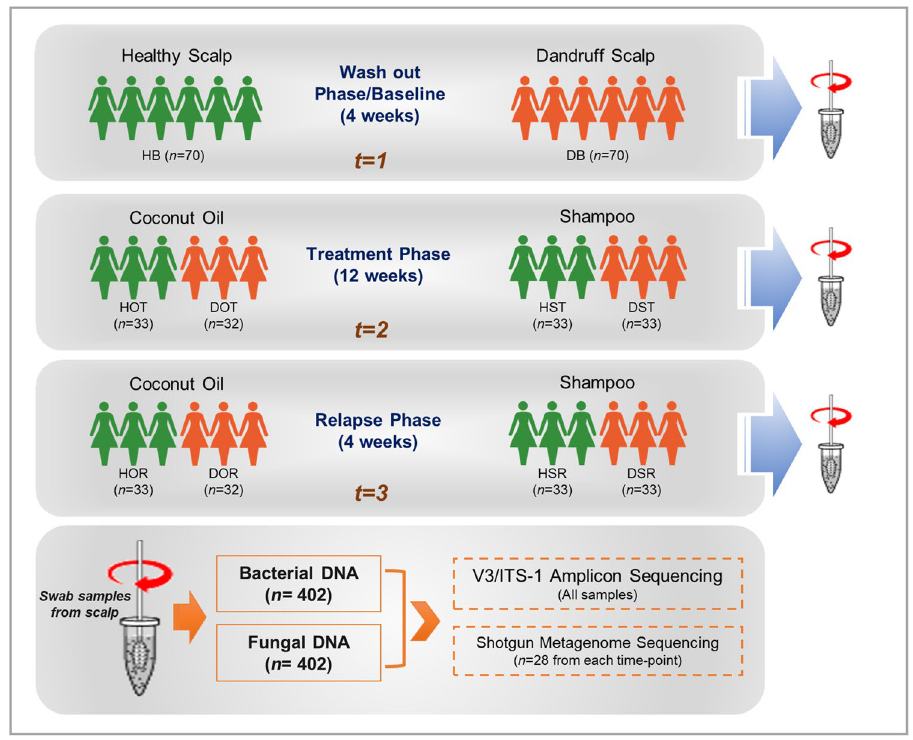
Figure 1. Study Design. Swab samples were collected at three phases, baseline ( t = 1), treatment phase ( t = 2) and relapse phase ( t = 3) from healthy and dandruff scalps. Bacterial and fungal DNA was extracted from the collected swab samples, and amplicon (bacterial 16S rRNA V3 and fungal ITS1 region) and shotgun metagenomic sequencing were performed to carry out the taxonomic and functional analysis. In the figure, H = healthy scalp, D = dandruff scalp, O = oil-treatment, S = shampoo-treatment, and B, T and R = the three phases or time-points i.e. Baseline, Treatment and Relapse phase, and n = number of subjects in each